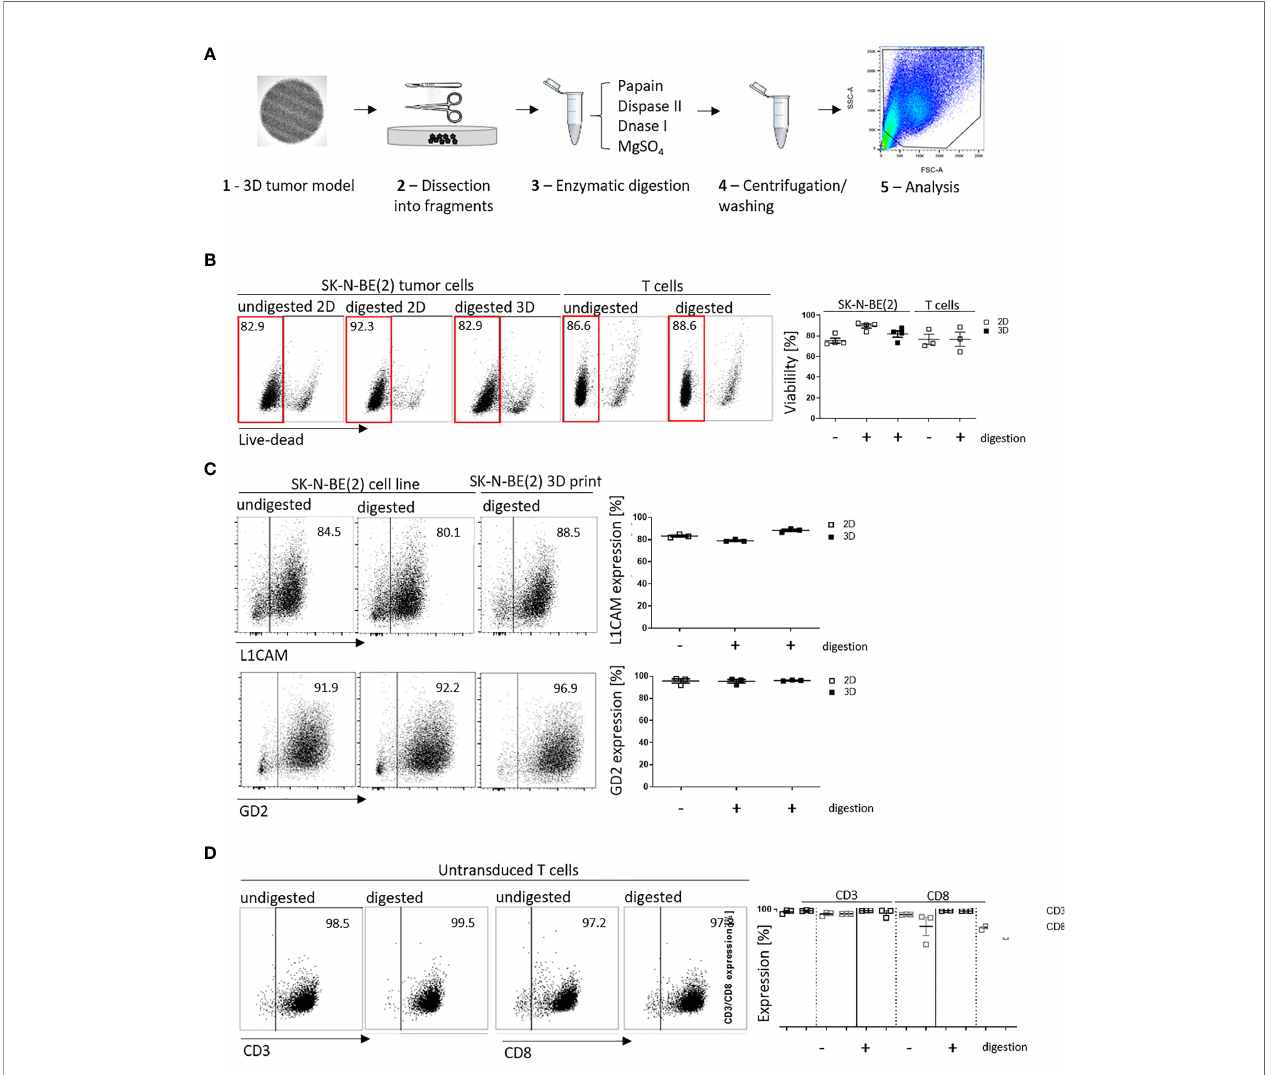
FIGURE 4 | Cell viability and cell surface molecule expression is maintained after enzymatic digestion. (A) Schematic depiction of enzymatic digestion protocol to produce single-cell suspensions after 3D model experiments. (B) Representative fl ow cytometry plots (left) showing live (framed in red) and dead cells that either underwent the enzymatic digestion protocol or not (from either 2D or suspension cultures) and the single-cell suspension from the 3D models. Numbers at the top of each plot indicate percent of the total cell population. SK-N-BE (2) neuroblastoma and untransduced T cells are shown in separate panels of the representative fl ow cytometry plots. Scatter plots on the right summarize results from 3 or 4 individual experiments. (C) L1CAM and GD2 antigen expression analyzed by fl ow cytometry (representative plots shown, left), and is summarized from 3 experiments in the scatter plot (right). (D) Representative CD3 + and CD8 + surface molecule expression on untransduced T cells without and with enzymatic digestion are shown (left) and summarized in the scatter plot (n = 3, right). All experiments were conducted after 24h of